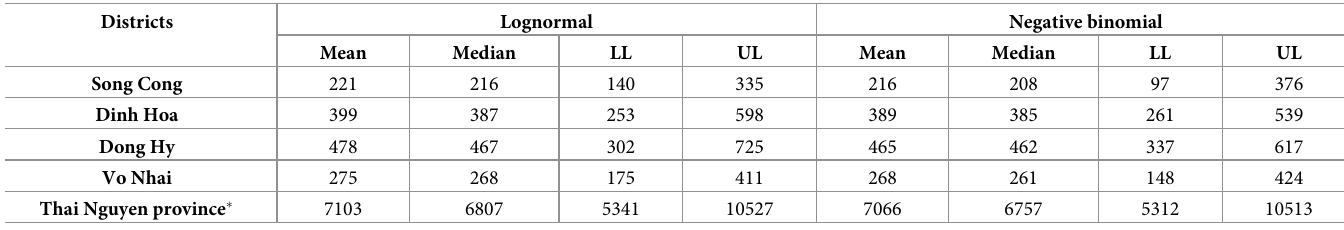
Table 4. Modeled CI estimates.